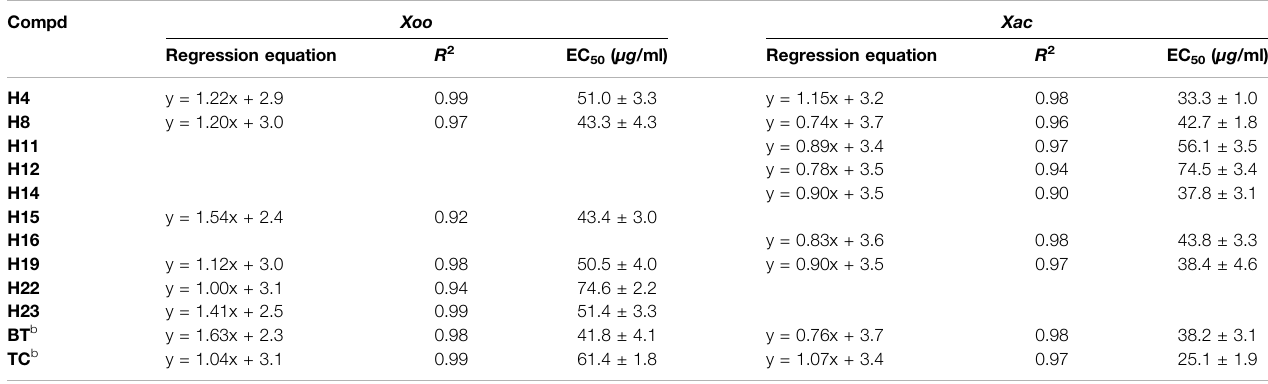
TABLE 2 | Antibacterial activities of some target compounds against Xoo and Xac in Vitro a . Compd